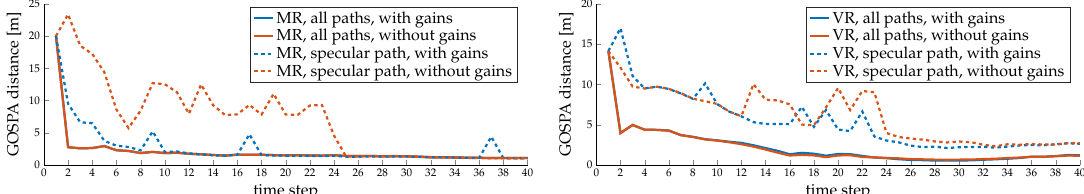
( d ) The comparison of mapping results for VR among four settings. Figure 10. Comparison of GOSPA results among four different settings.